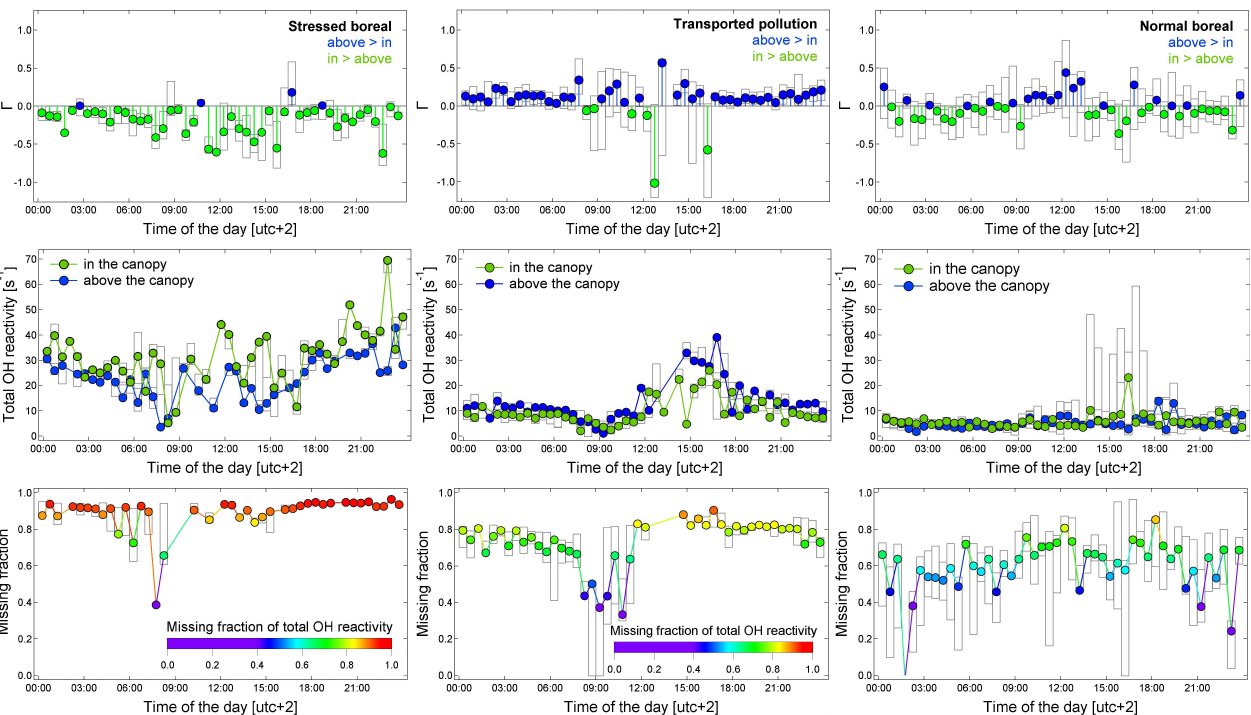
Fig. 4. Median diel variation for 0 , total OH reactivity measurements (in and above canopy) and missing fraction. Three characteristic regimes are shown: stressed boreal, transported pollution and normal